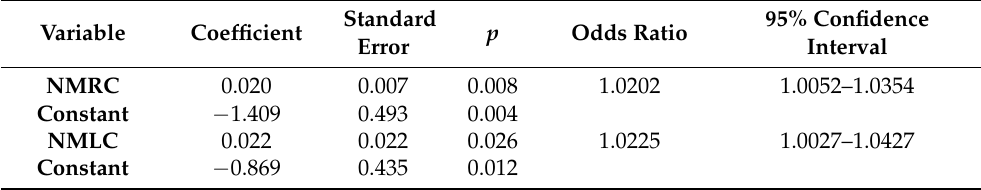
Table 5. MAPLC3 protein expression in the normal mucosa of the right colon (NMRC) and in the left colon (NMLC) according to the presence of at least one colorectal adenoma at colonoscopy, by logistic regression.